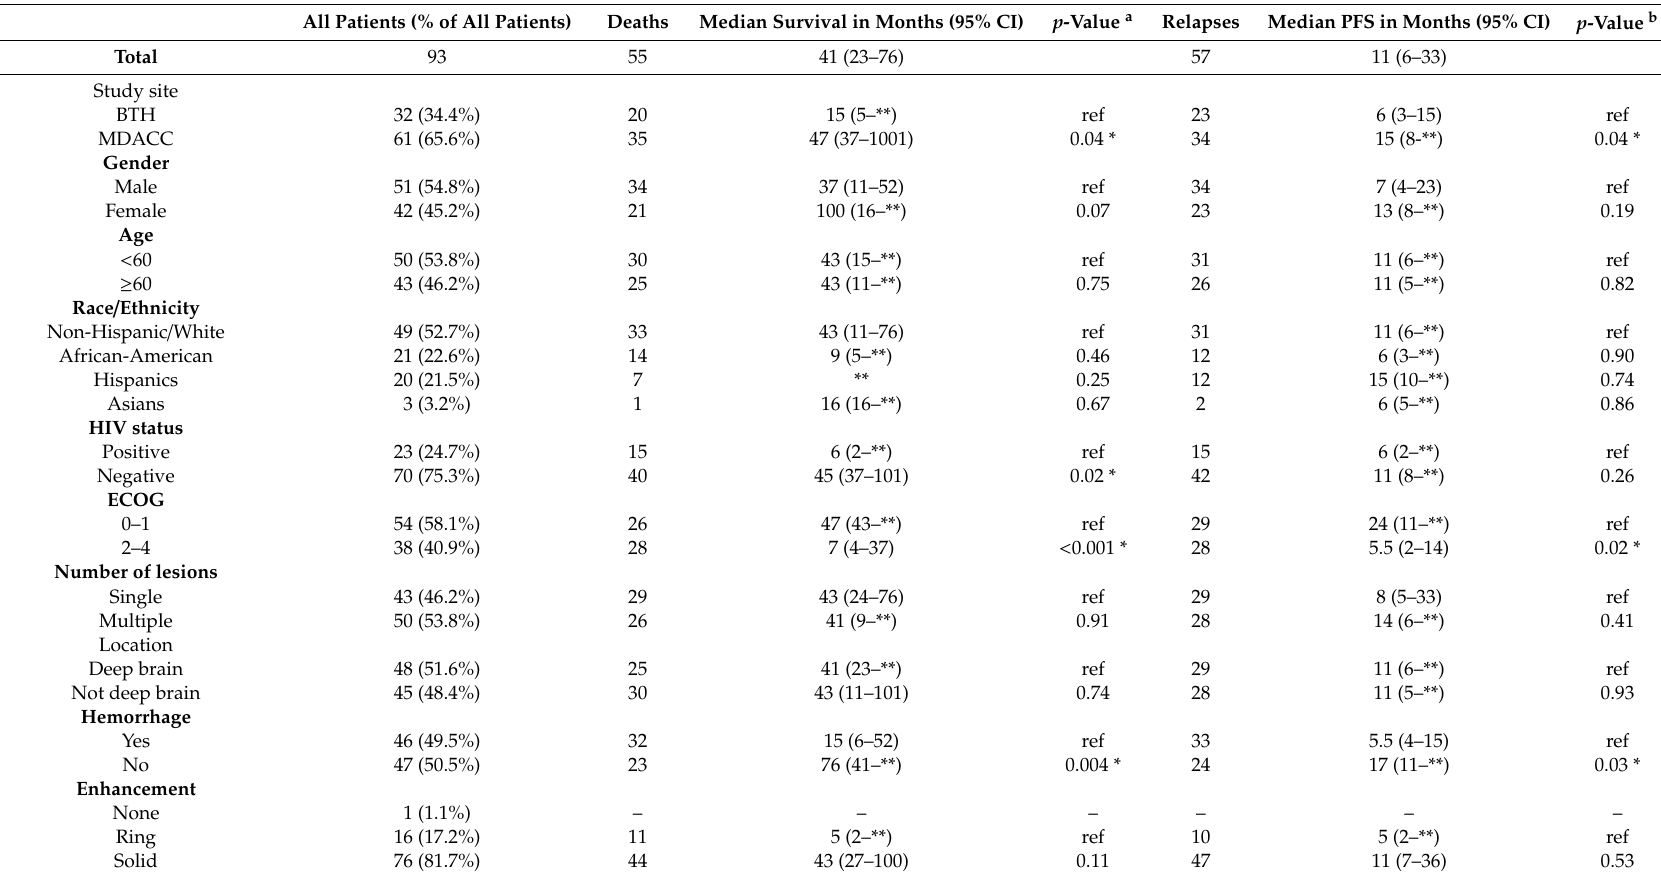
Table 1. Patient information and qualitative imaging characteristics. Results are considered significant (*) when p < 0.05. All Patients (% of All